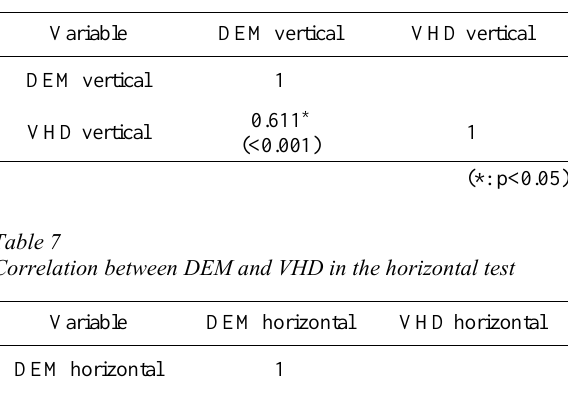
Correlation between DEM and VHD in the vertical test